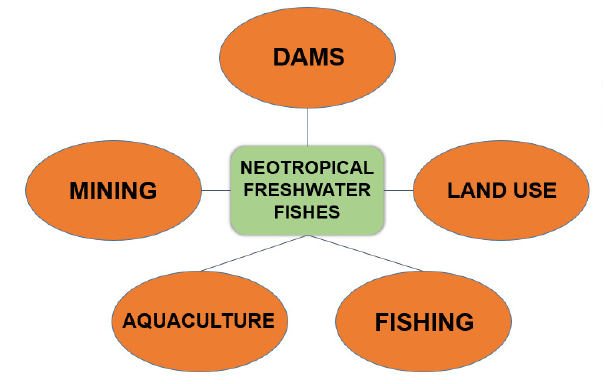
FIGURE 3 | Main human stressors associated with the loss of Neotropical freshwater fishes, investigated by studies published in this Special Issue of Neotropical